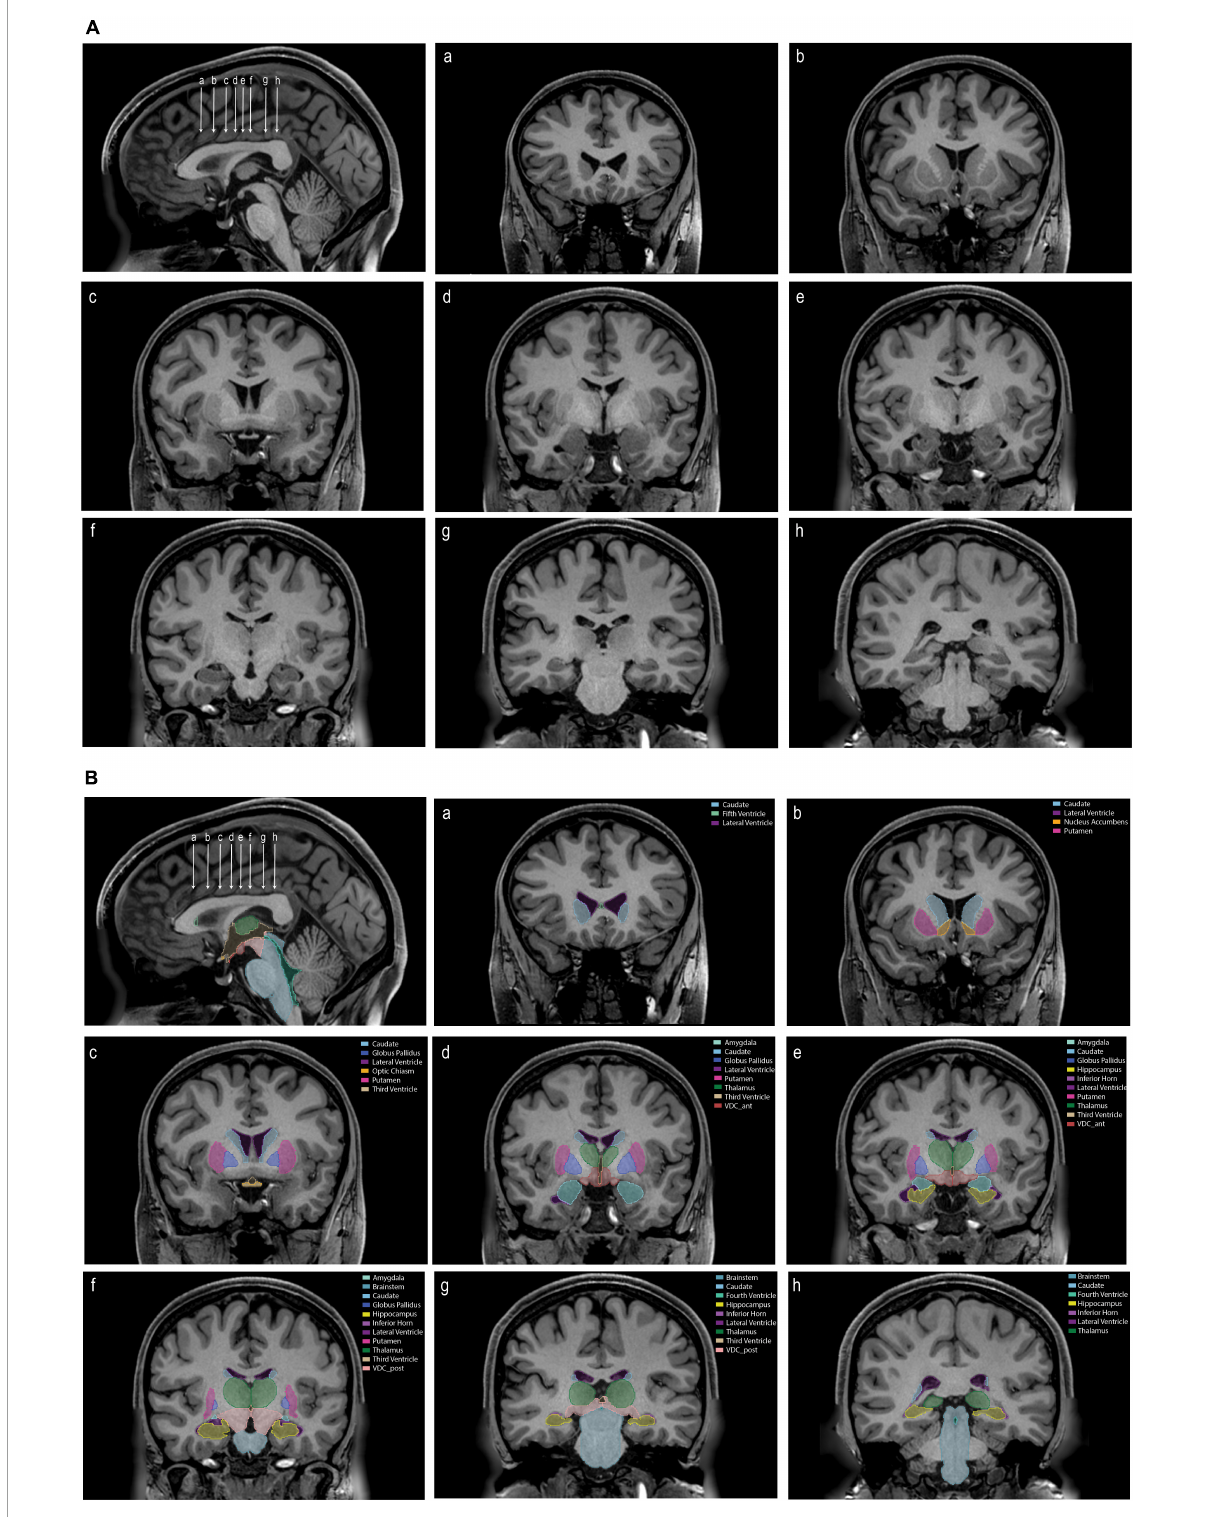
FIGURE3 (A) An unlabeled sagittal image (upper left) showing the position of eight coronal sections (a–h) . (B) The same images as in panel (A) labeled with the tools and procedures specified in this paper. Each labeled structure is color coded. Abbreviations: VDC_ant, anterior ventral diencephalon; VDC_post, posterior ventral